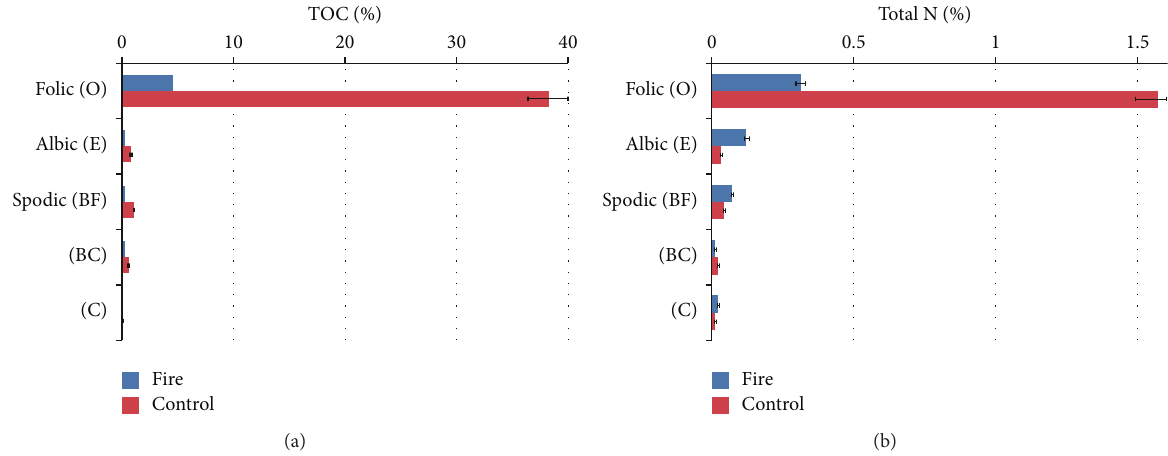
Figure 3: The profile distribution of total organic carbon (a) and nitrogen